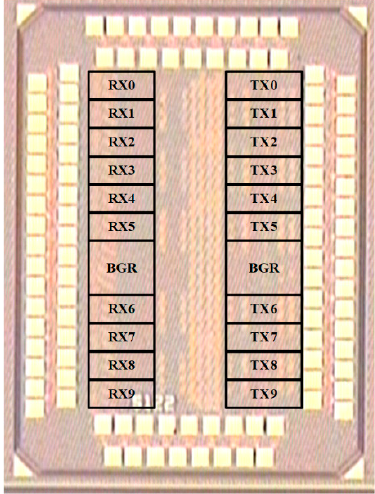
Figure 10. Microphotograph of the LVDS transceiver.